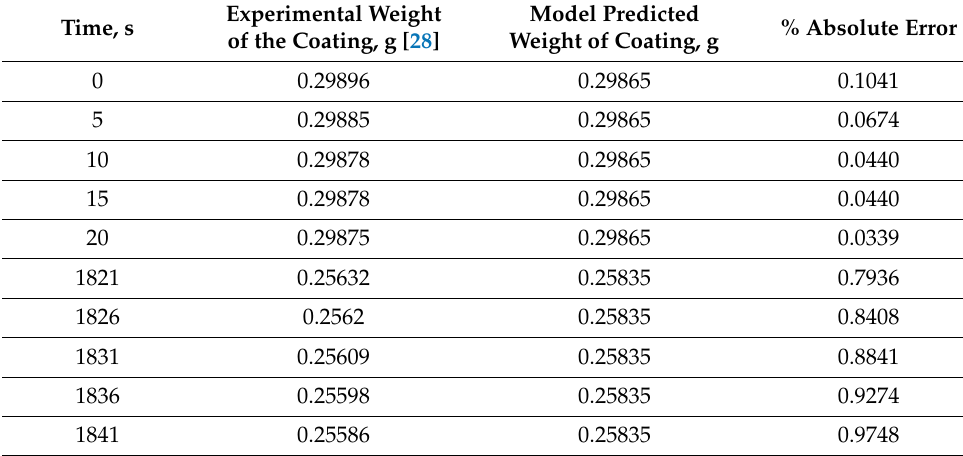
Table 4. Sample error between predicted and experimental values for 2005 µ m initial coating thickness with poly(styrene), p -xylene, and TPP contents of 5.02%, 93.47%, and 1.51%,